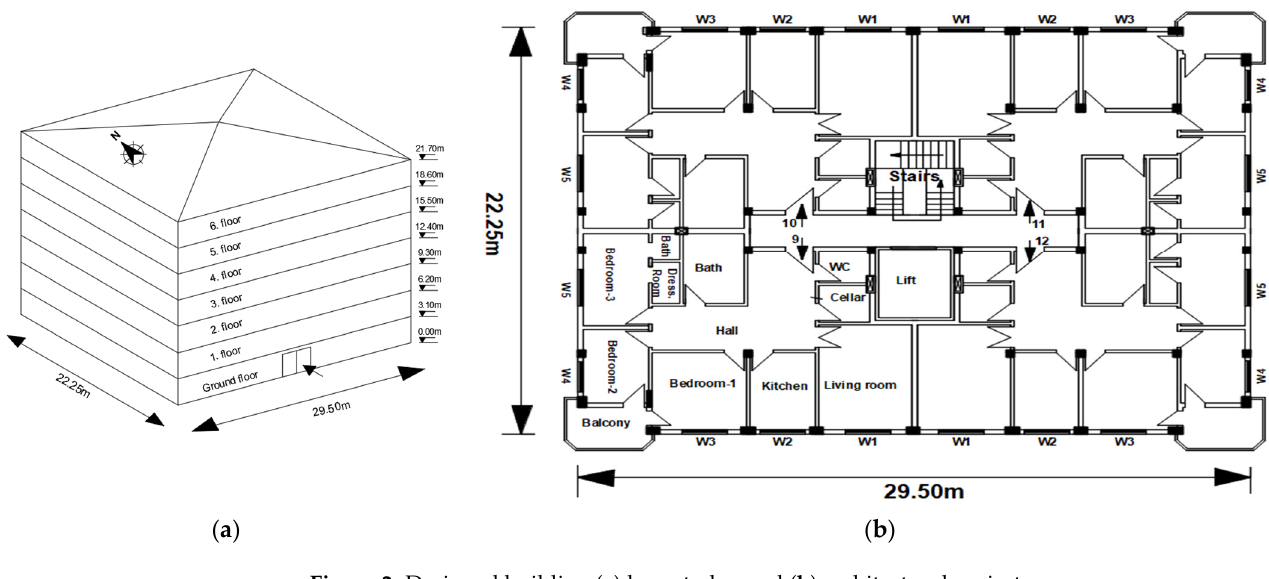
Figure 2. Designed building ( a ) layout plan and ( b ) architectural